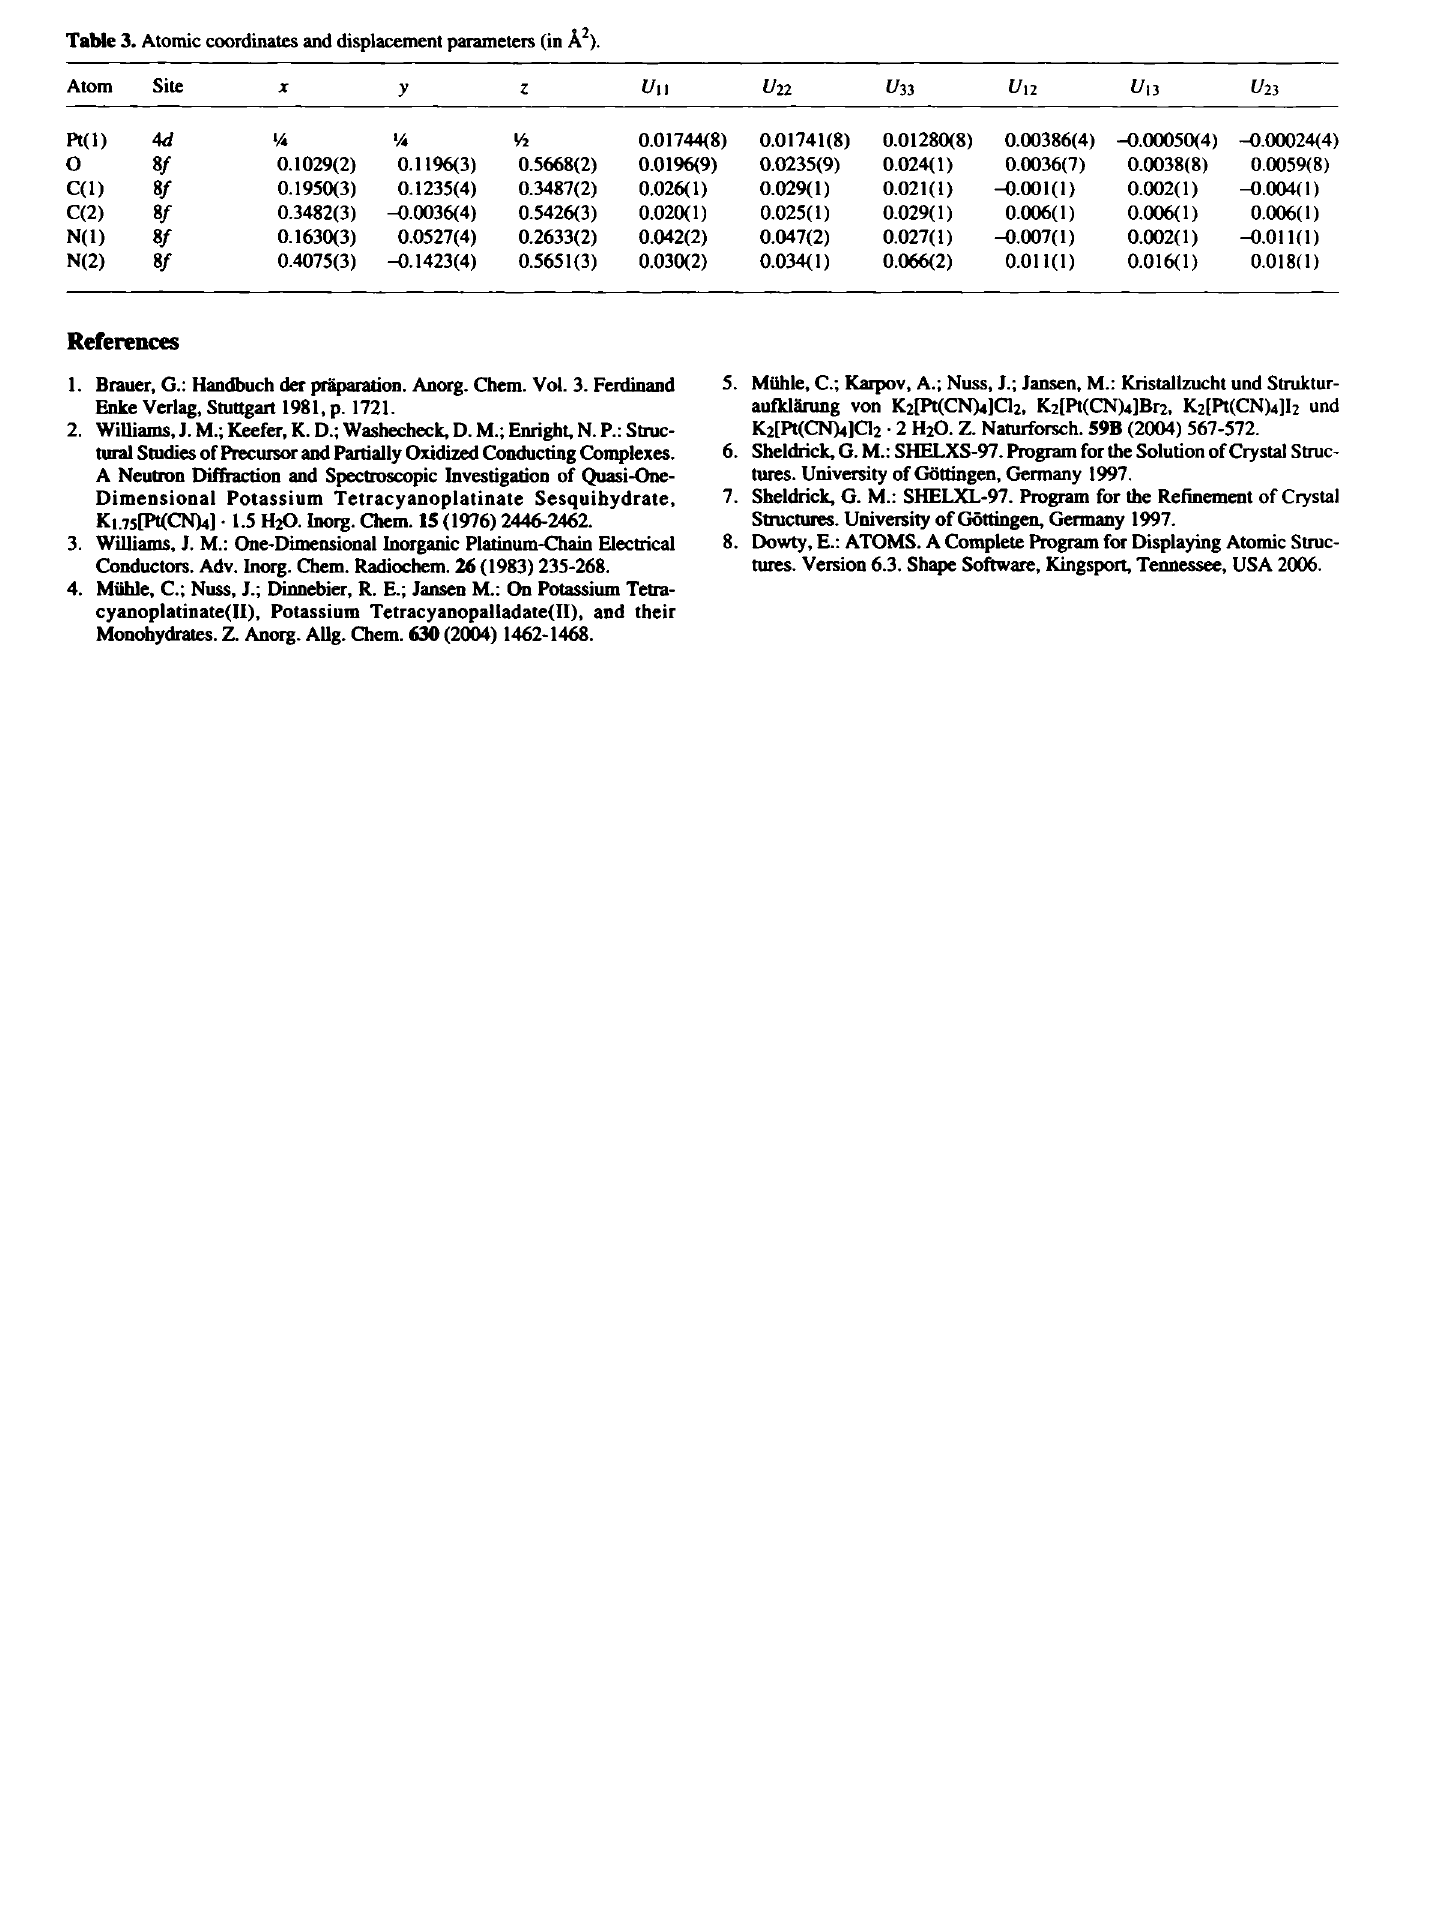
Table 3. Atomic coordinates and displacement parameters (in Â 2